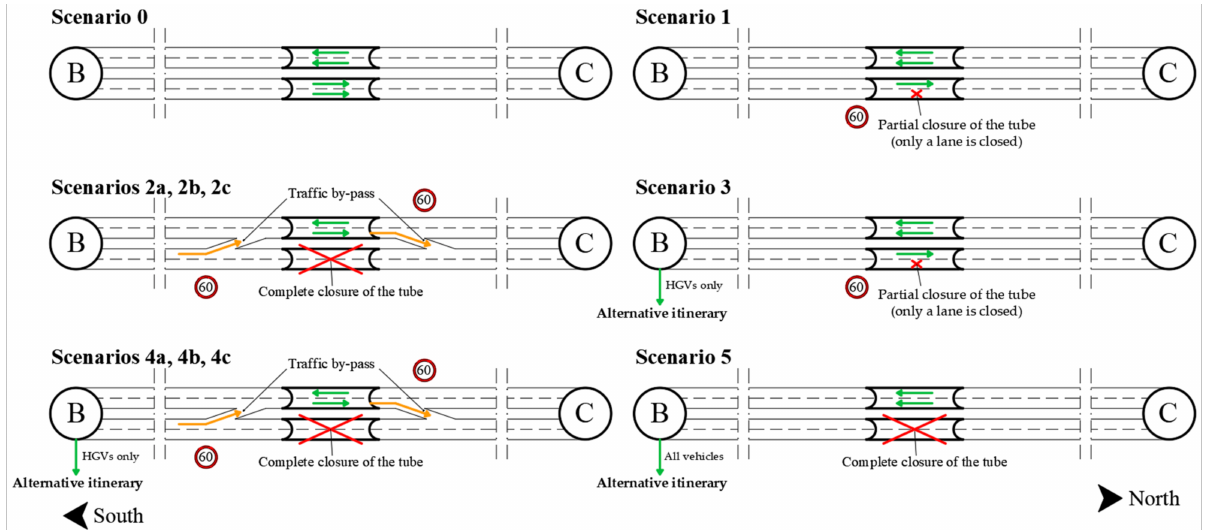
Figure 3. Schematic representation of the scenarios investigated. Scenario 0: ordinary functionality of each tunnel tube without any disruptive event; Scenario 1: partial closure of the tube (only one lane is closed); Scenario 2: complete closure of the tube and use of the adjacent one for bi-directional traffic with the traffic by-pass opening within 10 min (Scenario 2a), 20 min (Scenario 2b), and 30 min (Scenario 2c), respectively; Scenario 3: partial closure of the tube with alternative itinerary used by HGVs only; Scenario 4: complete closure of the tube and use of the adjacent one for bi-directional traffic with alternative itinerary used by HGVs only, and traffic by-pass opening within 10 min (Scenario 4a), 20 min (Scenario 4b), and 30 min (Scenario 4c), respectively; Scenario 5: complete closure of the tube with alternative itinerary used by all the vehicles of the motorway section traveling towards the north tube.